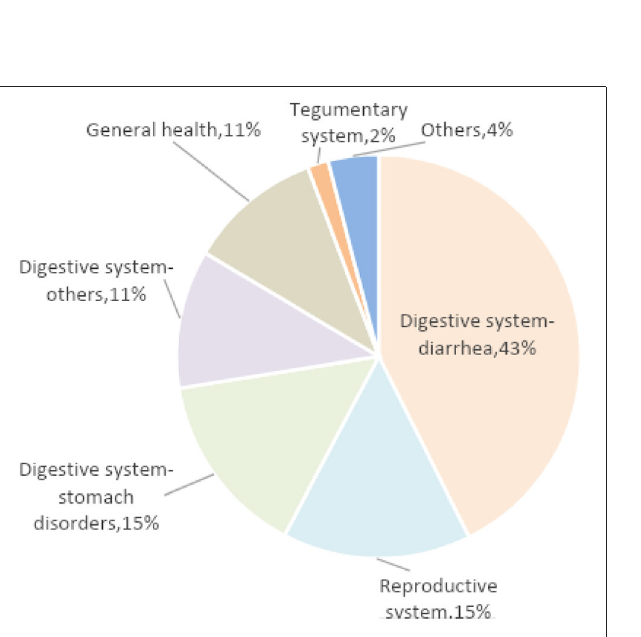
FIGURE 5 | Distribution of detailed use reports (DUR) related to cattle ethnoveterinary